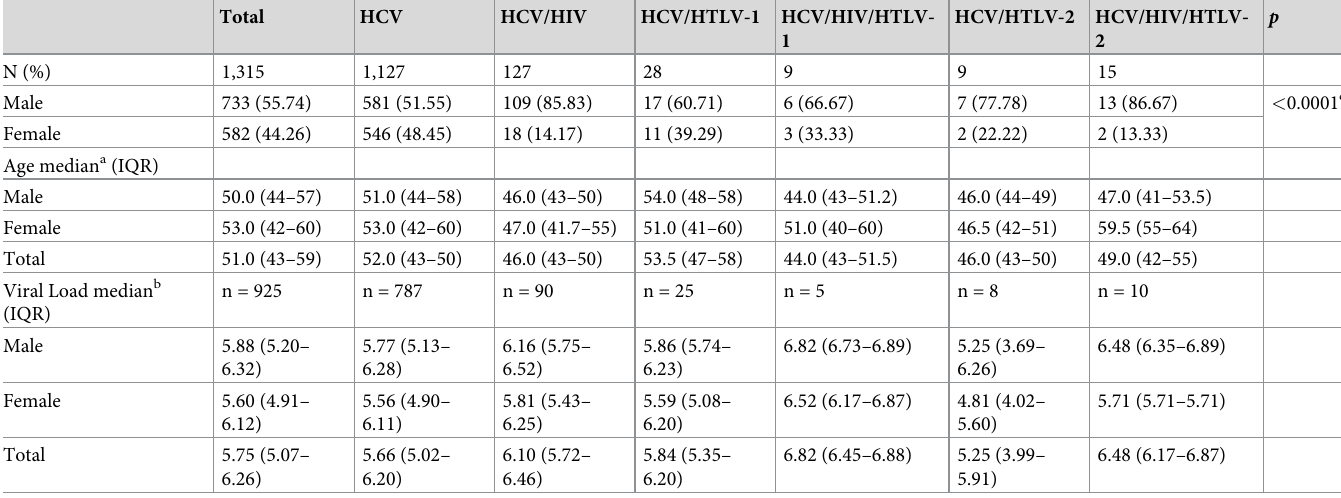
Table 2. Characteristics of the study population and results of HCV viral load according to the type of infection and